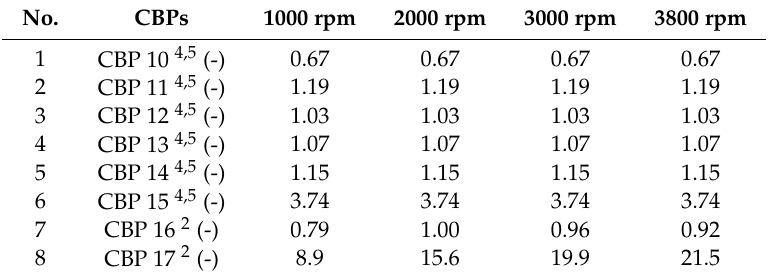
Table 8. Evaluated CBPs (Table 1) in calibration loop 2 at full-load operating